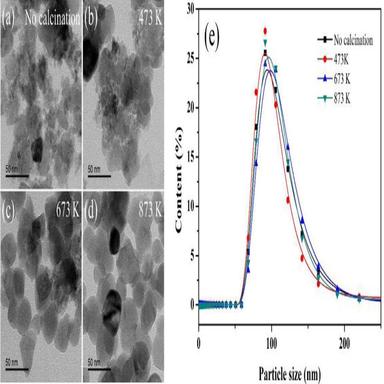
Precursor powders calcined at different temperatures: (a–d) TEM images; (e) particle size distribution.